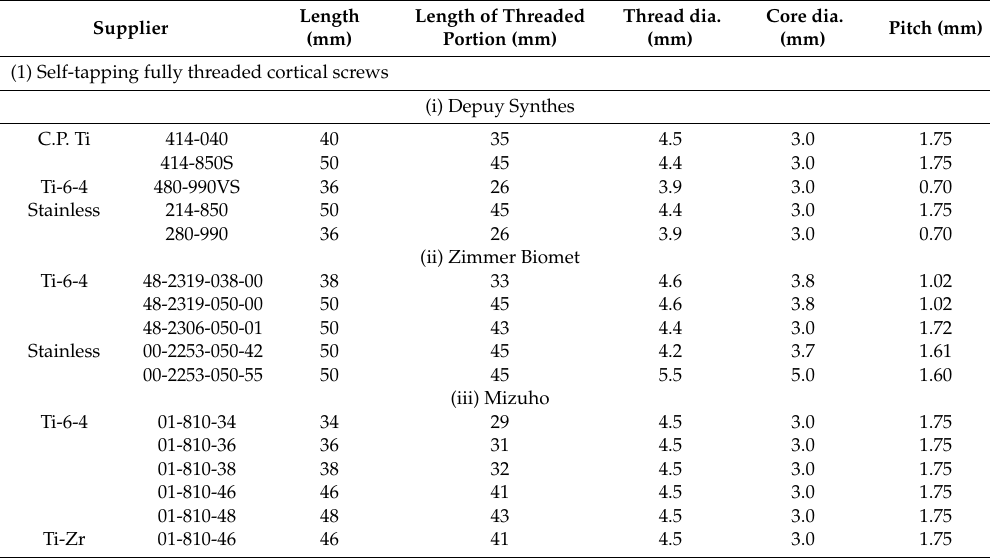
Table 1. Various orthopedic screws used in this study.